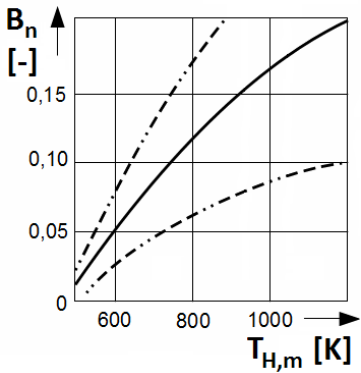
Fig. 2 Beale number according to mean temperature